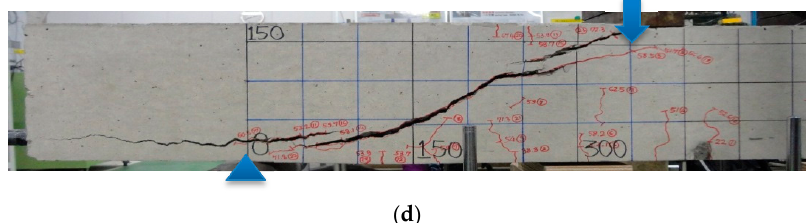
Figure 17. Failure mode of the small RC beams. ( a ) Beam NS60; ( b ) beam HS60; ( c ) beam MS60; and ( d ) beam LS60.